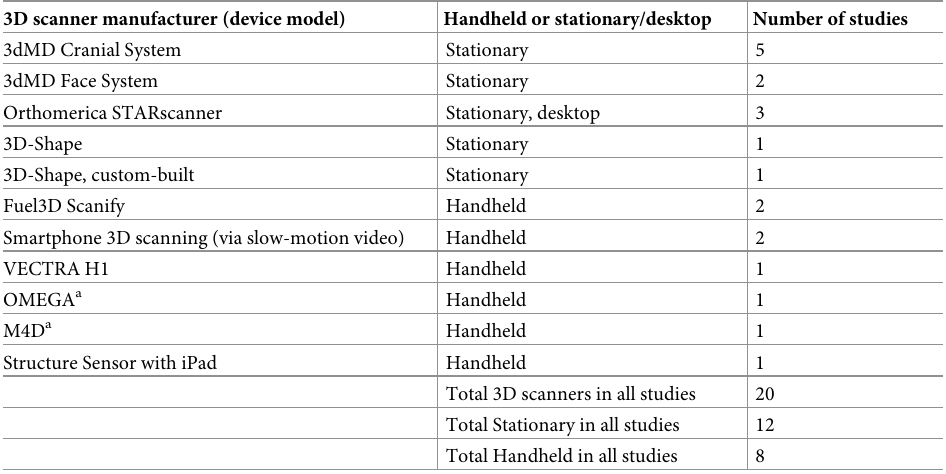
Table 3. Used 3D scanner device models. 3D scanner manufacturer (device